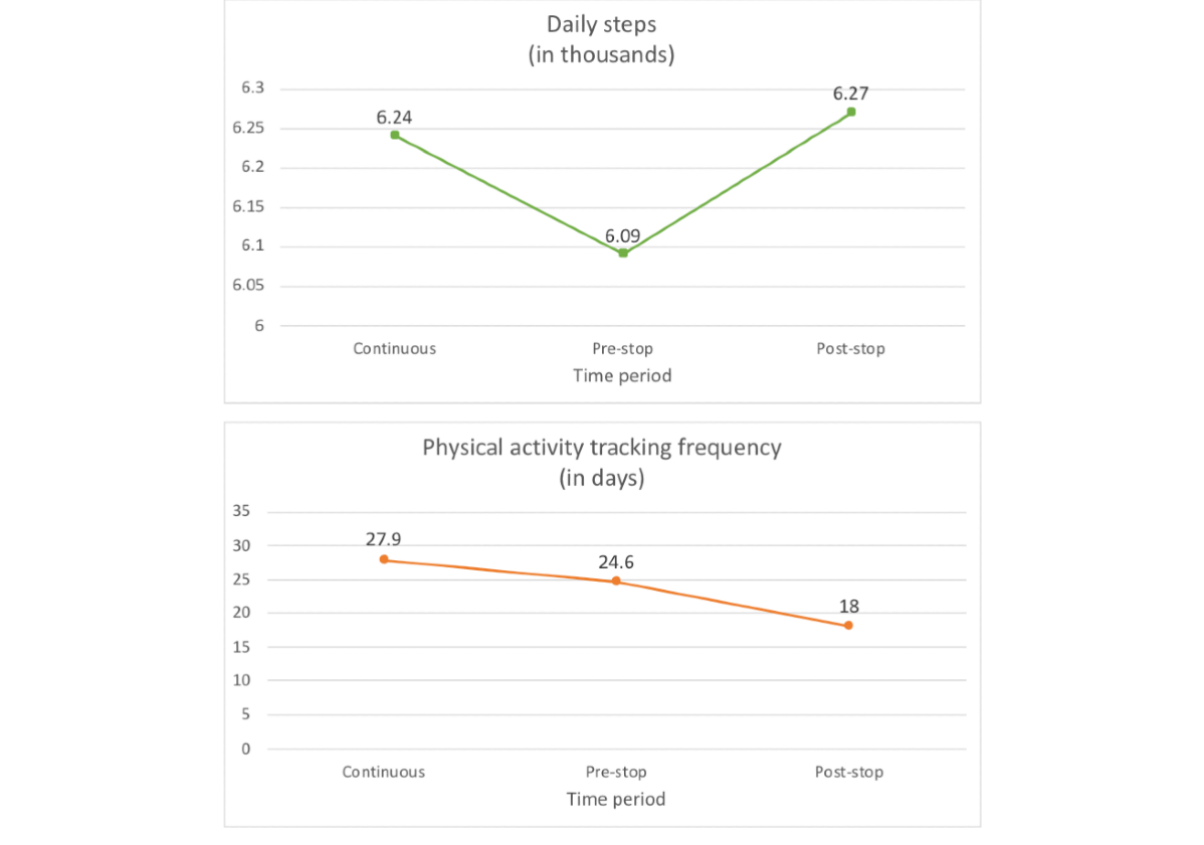
Figure 7. Results of the linear mixed effects models for research question 2.